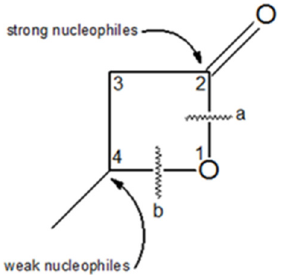
Figure 1. β -butyrolactone molecule with carbon description and possible nucleophile attack positions in anionic BL polymerization.